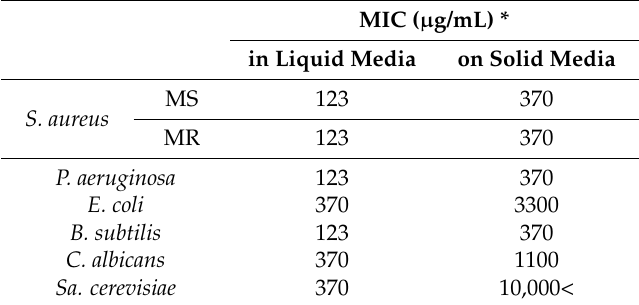
Table 1. Minimum inhibitory concentrations (MICs) of poly(METAC) synthesized in this